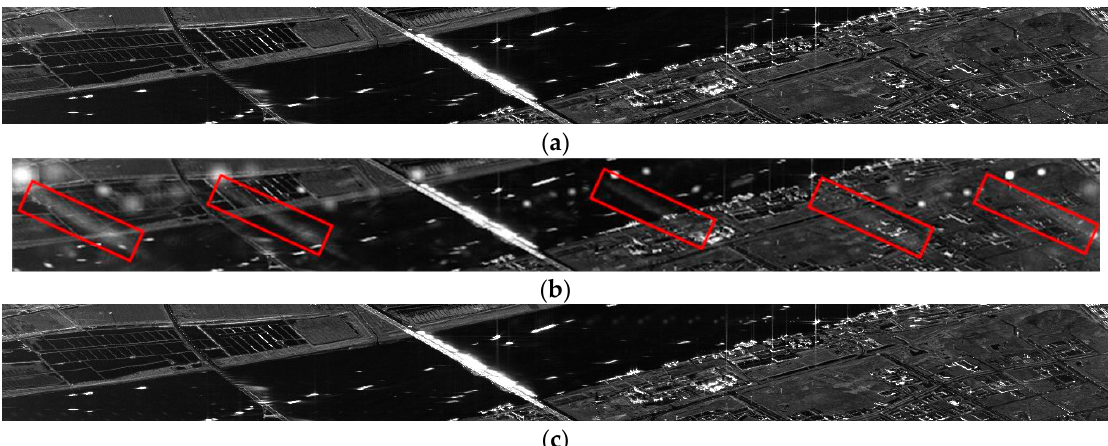
Figure 7. Sub-area of the train in Figure 6. ( a ) Result of conventional two-step processing approach without data-preprocessing. ( b ) Result of conventional two-step processing approach with data-preprocessing. ( c ) Result of modified two-step processing approach (based on modified sinc interpolation) with data-preprocessing.